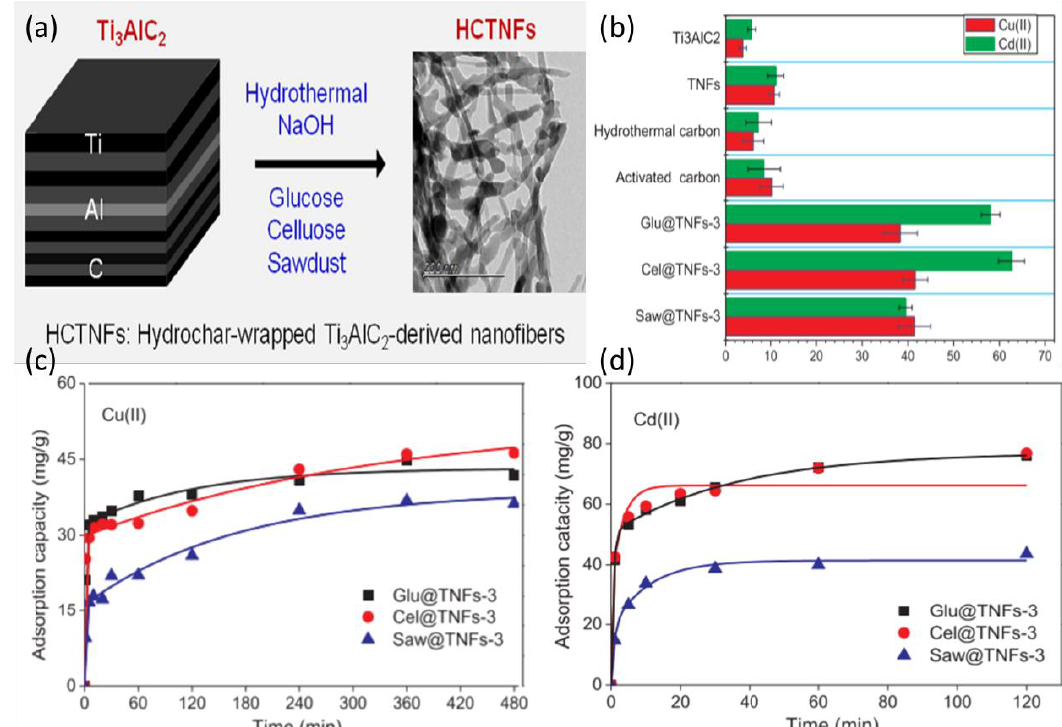
Figure 8. ( a ) Preparation of hydrochar-wrapped, Ti 3 AlC 2 -derived nanofibers (HCTNFs). ( b ) Adsorption capacities of Ti 3 AlC 2 , TNFs, hydrothermal carbon, activated carbon, and typical HCTNFs for Cu(II) and Cd(II). Effect of contact time on the adsorption capacities of Glu@TNFs-3, Cel@TNFs-3, and Saw@TNFs-3 for ( c ) Cd(II) and ( d ) Cu(II). Conditions: pH of Cd = 6, pH of Cu = 5, with initial concentration 100 mg/L for each metal, m/V = 1 g/L, and T = 25 °C Adapted and reproduced with a permission from [80] . Copyright 2019 Elsevier.